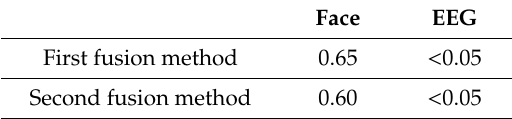
Table 4. The results of statistical tests in the MAHHNOB-HCI dataset in valence space.